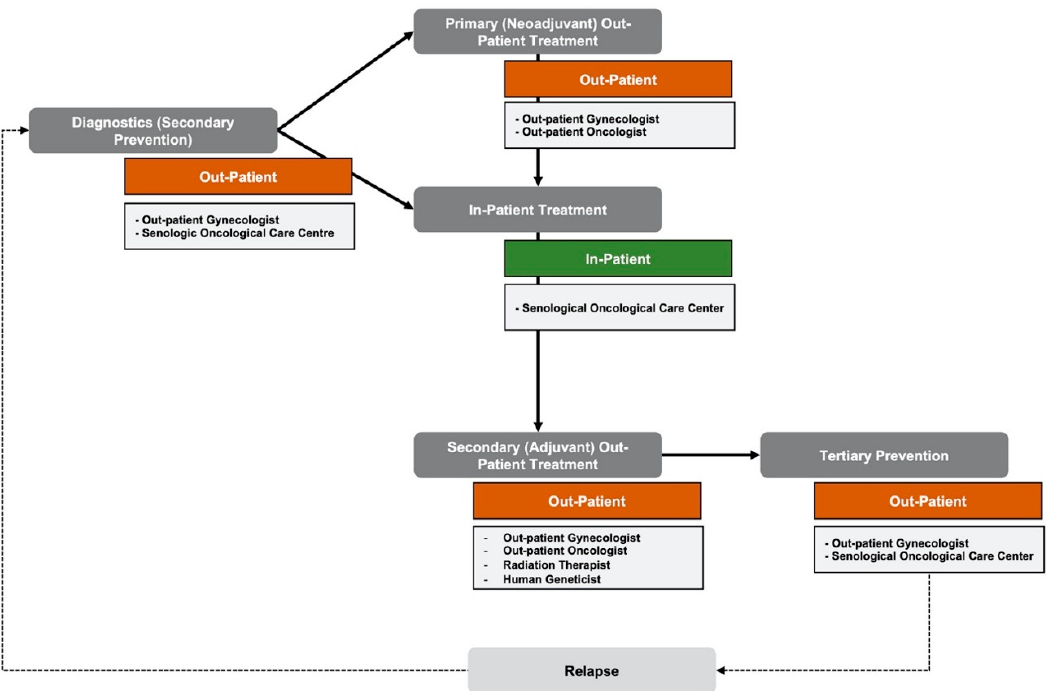
Figure 2. Overview of the breast cancer care workflow based on the German guideline.